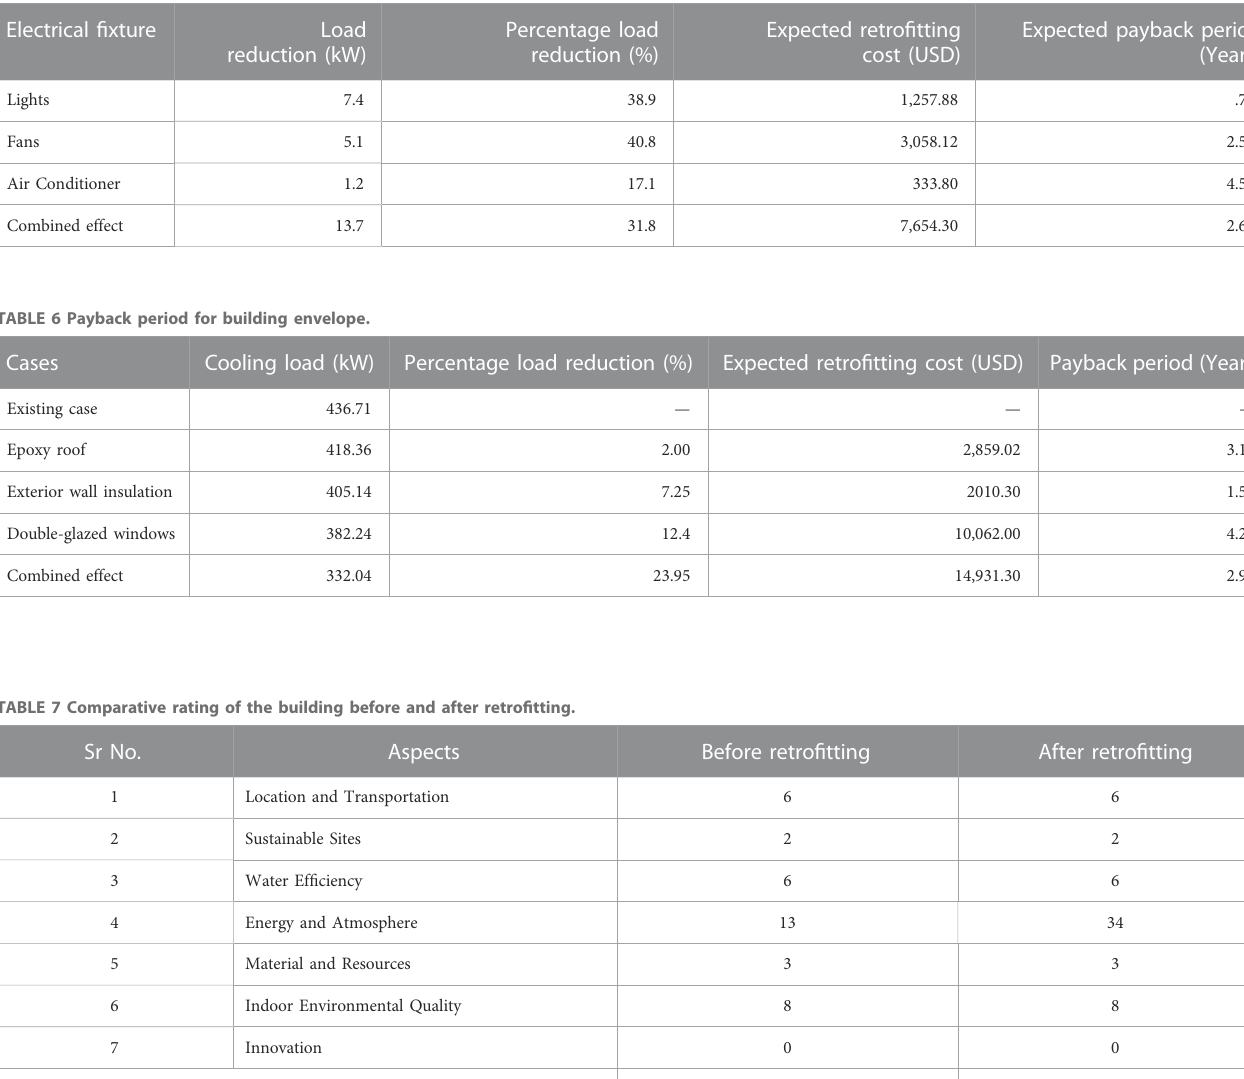
TABLE 5 Payback period for electrical fi xtures.